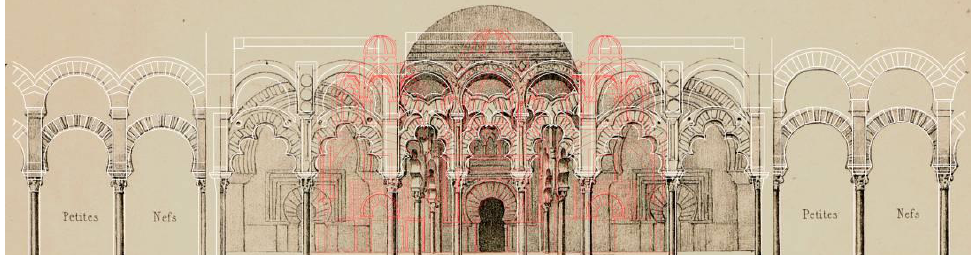
Figure 21. Girault de Prangey (1839): Digital model (white foreground and red background) overlapping the surroundings of the mihrab. Source: Own production.